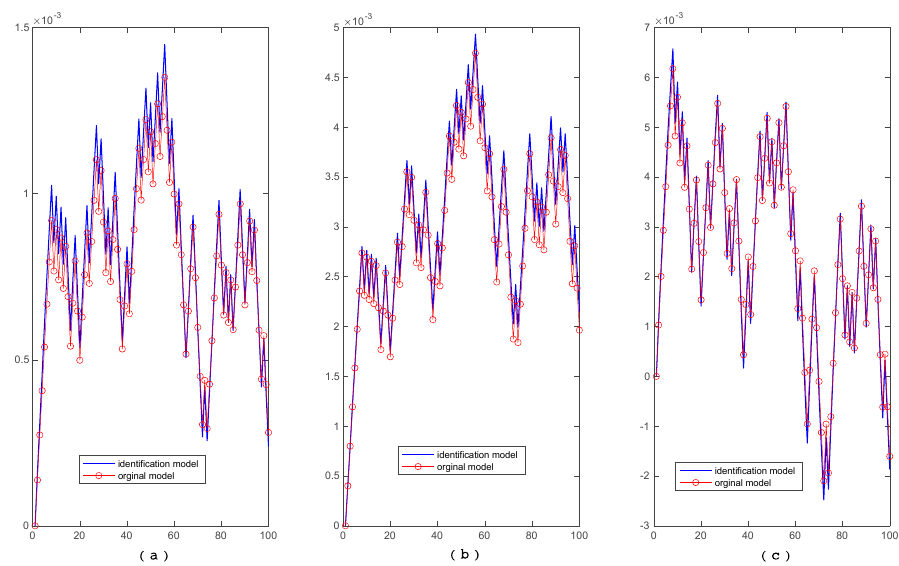
Figure 1. Open-loop output between the identification model and CSTR. ( a ) The open-loop output between Mode1 and CSTR. ( b ) The open-loop output between Mode2 and CSTR. ( c ) The open-loop output between Mode3 and CSTR.